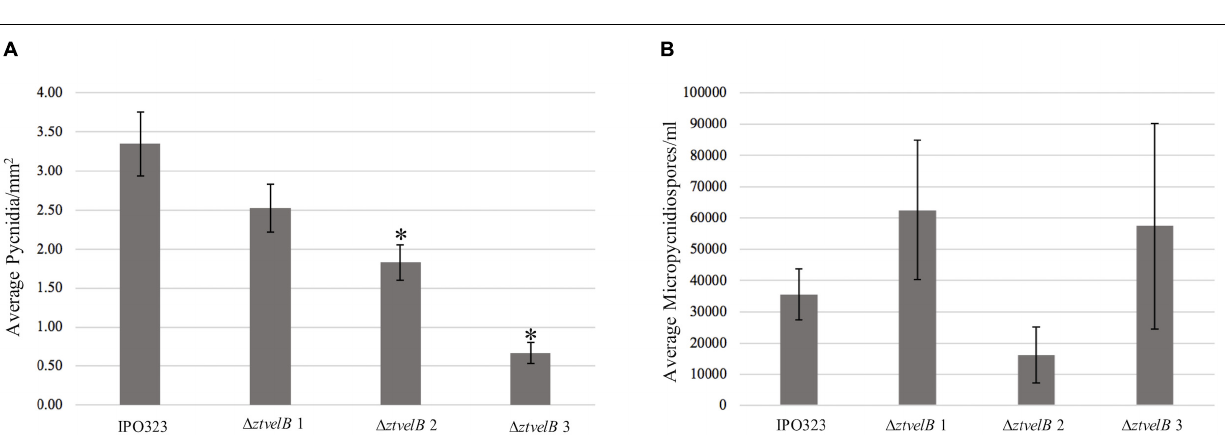
the spore suspensions obtained from all three (cid:49) ztvelB mutant strains only produced micropycnidiospores ( Supplementary Figure S5 ). Taken together, these results demonstrate that the micropycnidiospores produced by the (cid:49) ztvelB mutant pycnidia are viable and capable of causing infection on the wheat